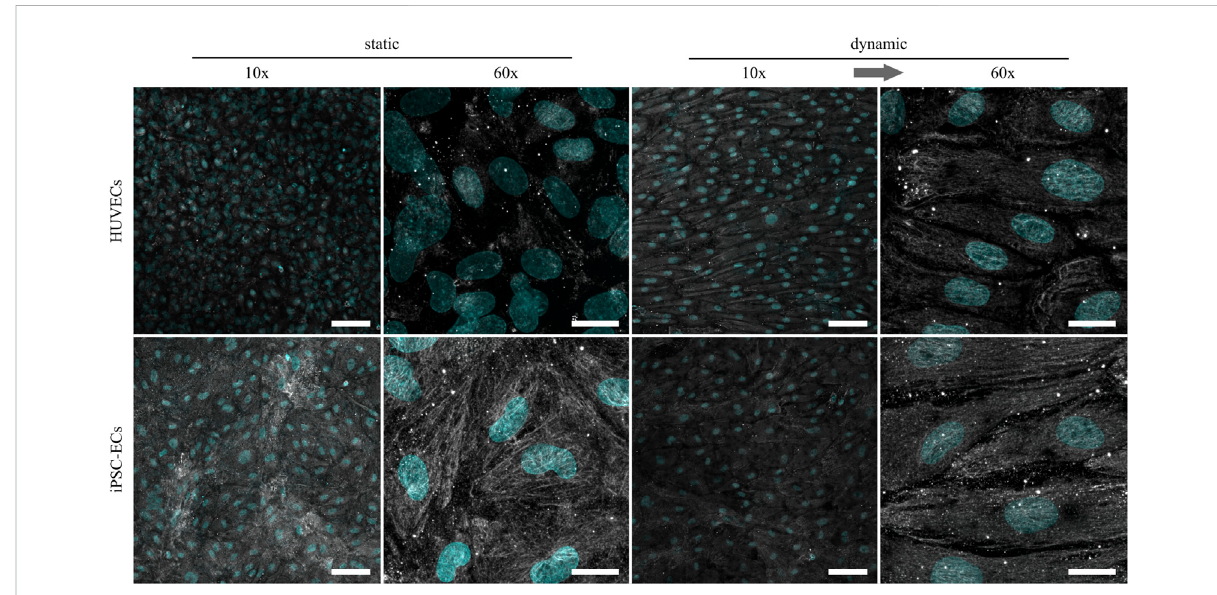
FIGURE 3 Representative confocal immuno fl uorescence images of a chondroitin sulfate staining (grey) of HUVECs and iPSC-ECs after 96 h of static and dynamic culture. Nuclei were counterstained with Hoechst 33342 (cyan). (Arrow indicates fl ow direction. Scale bars: 10× 100 µm, 60× 20 µm).